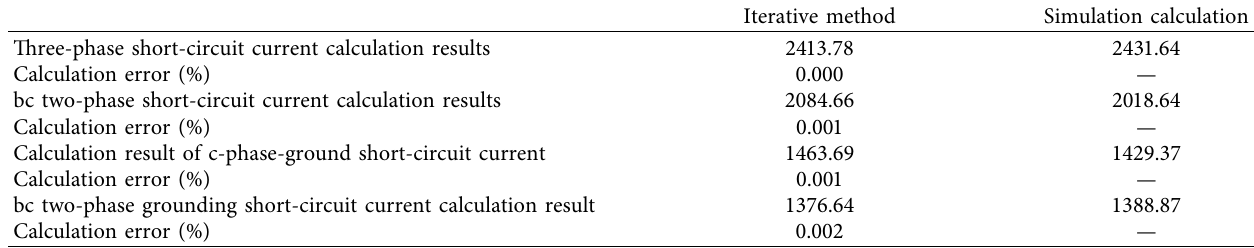
Table 4: Calculation results of short-circuit current in the case of 4-node faults in the distributed power distribution network with inverters.